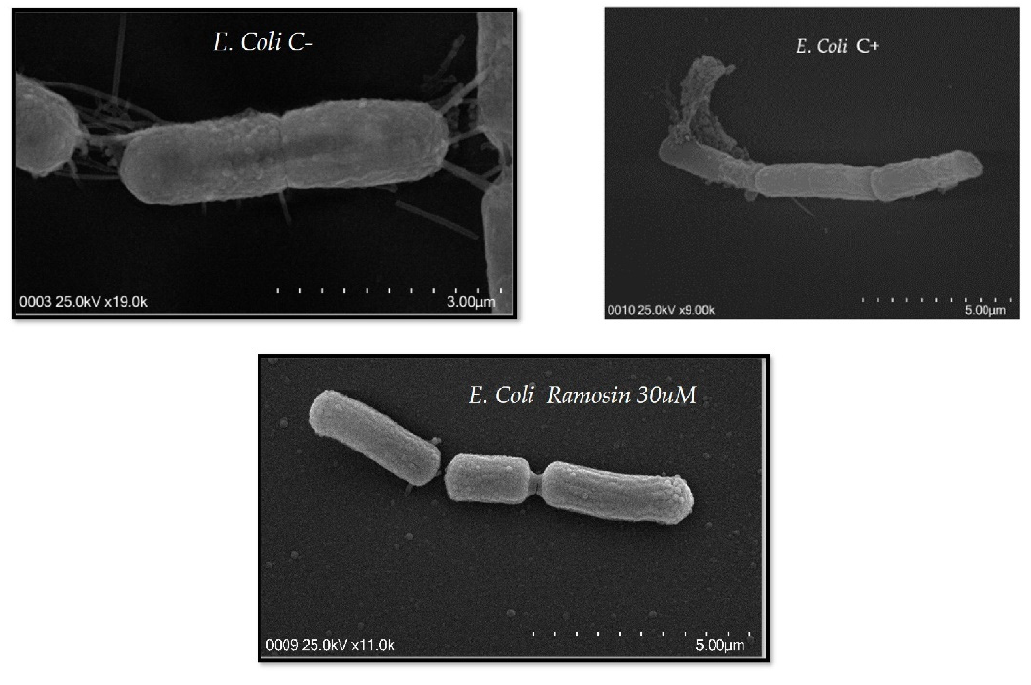
Figure 5. Scanning electron microscopy of the Gram-negative bacteria E. coli . Bacteria were treated with Ramosin peptide at 30 μ M. C-: E. coli without treatment. C+: BTM-P1 peptide at 20 μ M [47].